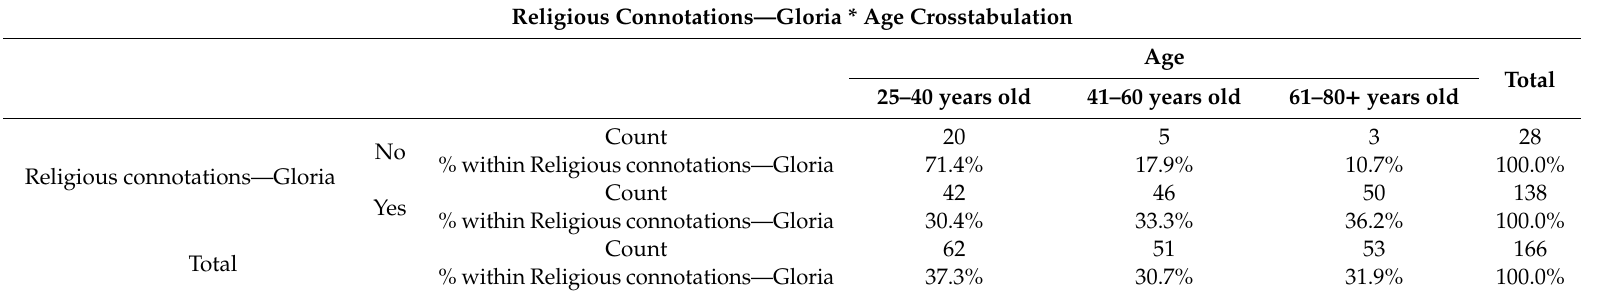
Table 3. Religious connotations in terms of age for the name Gloria in the metropolitan district of